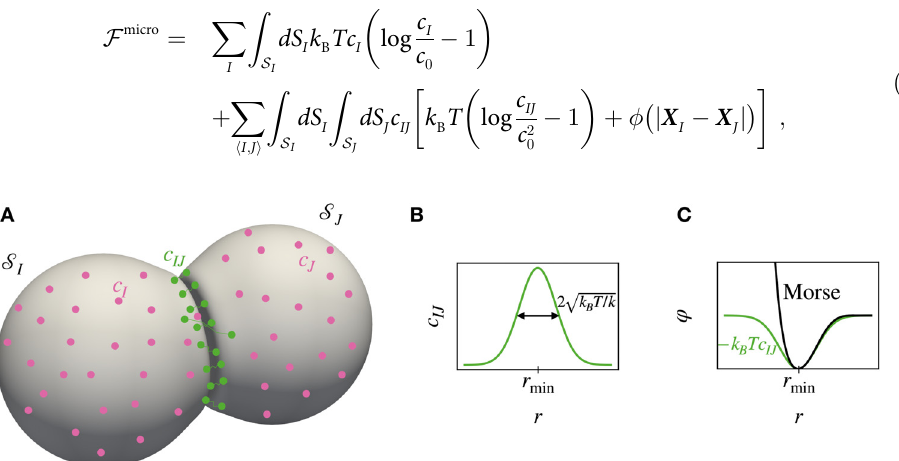
Fig 3. (A) Physical picture of two interacting cells, I and J , that adhere via stretchable linkers. The concentrations c I and c J describe the number of free linkers in cells I and J per unit area. When free linkers from cells I and J are in close proximity, they can react to generate a linker joining the two cells. The ensemble of connected linkers is characterised by a two-point concentration field c ( X , X ) with units of inverse of an area squared. (B) Concentration IJ I J of connected linkers as a function of the distance r = | X I − X J |, for linear elastic bonds with stiffness k and preferred elongation r min , fast equilibration of linker density and assuming that free linkers are in contact with a reservoir imposing their equilibrium concentration. (C) Green: effective potential of interaction of two points on two surfaces as a function of their distance r . Black: the Morse potential resembles the effective potential of interaction but with additional short-range